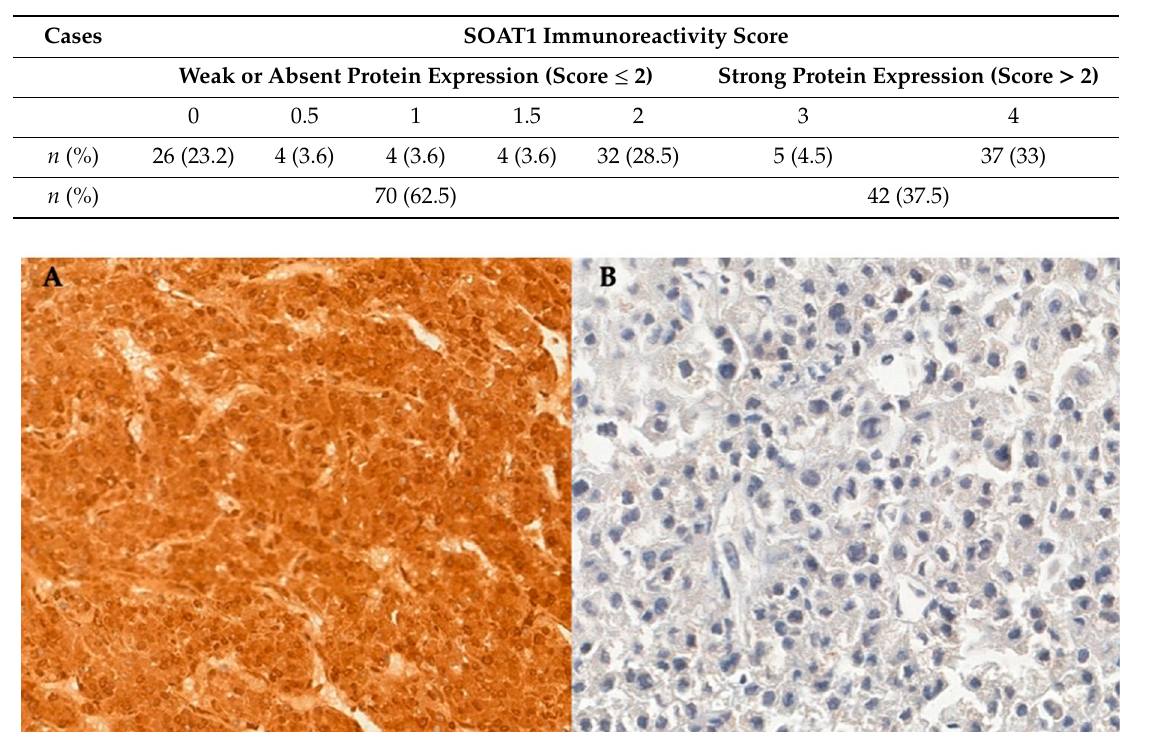
Figure 1. ( A ) Strong immunoreactivity (score 4) for SOAT1 in a cortisol-producing metastatic adrenocortical carcinoma (ACC) in a 30-year-old man presenting an unfavorable outcome with an overall survival of 16 months (400×). ( B ) Absent immunoreactivity (score 0) for SOAT1 in a non-functioning ACC in a 61-year-old woman presenting a favorable outcome after 42 months of follow-up (400×).